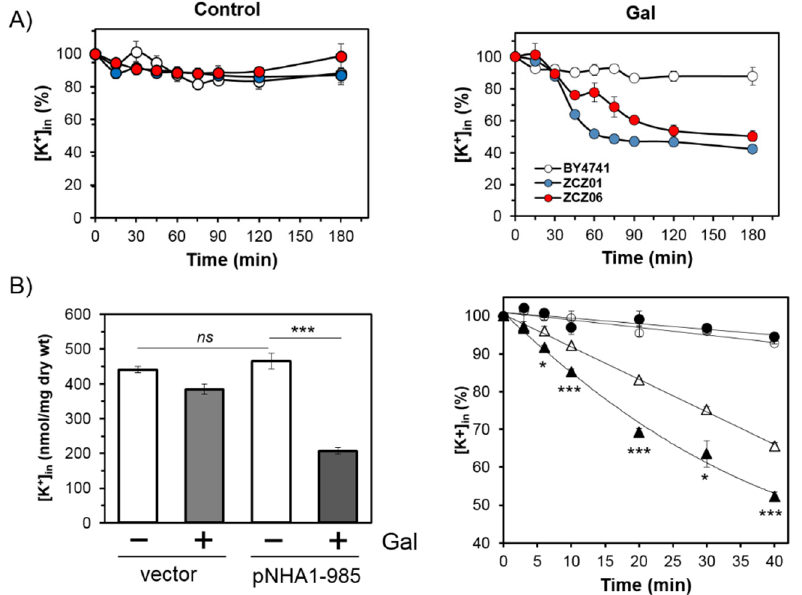
Figure 2. Overexpression of Ppz1 results in sharp decrease in intracellular potassium content and augmented Nha1-mediated K + efflux. ( A ) Time course of changes of intracellular K + content in strains BY4741 (wild-type; white), ZCZ01 ( GAL1:PPZ1 ; blue), and ZCZ06 ( GAL1:PPZ1 nha1 Δ ; red) grown in YNB plus 2% Raff and supplemented at time 0 min with galactose to induce the overexpression of Ppz1 (2% final concentration; right panel) or with water (control; left panel). The average initial concentrations of K + (taken as 100%) for all three strains were similar 618 ± 62 and 626 ± 84 nmol/mg dry weight under control or Gal-induced conditions, respectively. Statistics for this figure are offered as Supplementary Material (Table S1). ( B ) Determination of Nha1-mediated K + efflux. ZCZ06 cells carrying the empty vector (circles), or the pNHA1-985 plasmid (triangles) were grown on raffinose and split in two aliquots. Control cells received water (white bars and symbols), and Ppz1 was induced by adding galactose up to 2% (dark bars and symbols). After one h of incubation, cells were processed for measurement of K + efflux (c.f. Materials and Methods). Left panel, initial intracellular concentrations of K + at t = 0 of the efflux determination (taken as 100% for right panel; significant difference is indicated by asterisks *** p < 0.001; ns = not significant). Right panel, changes in K + content for the different strains and conditions. The results represent mean values obtained in three independent experiments ± SEM. Significant differences between cells expressing Nha1 are indicated with asterisks (*, p < 0.05; *** p < 0.001).